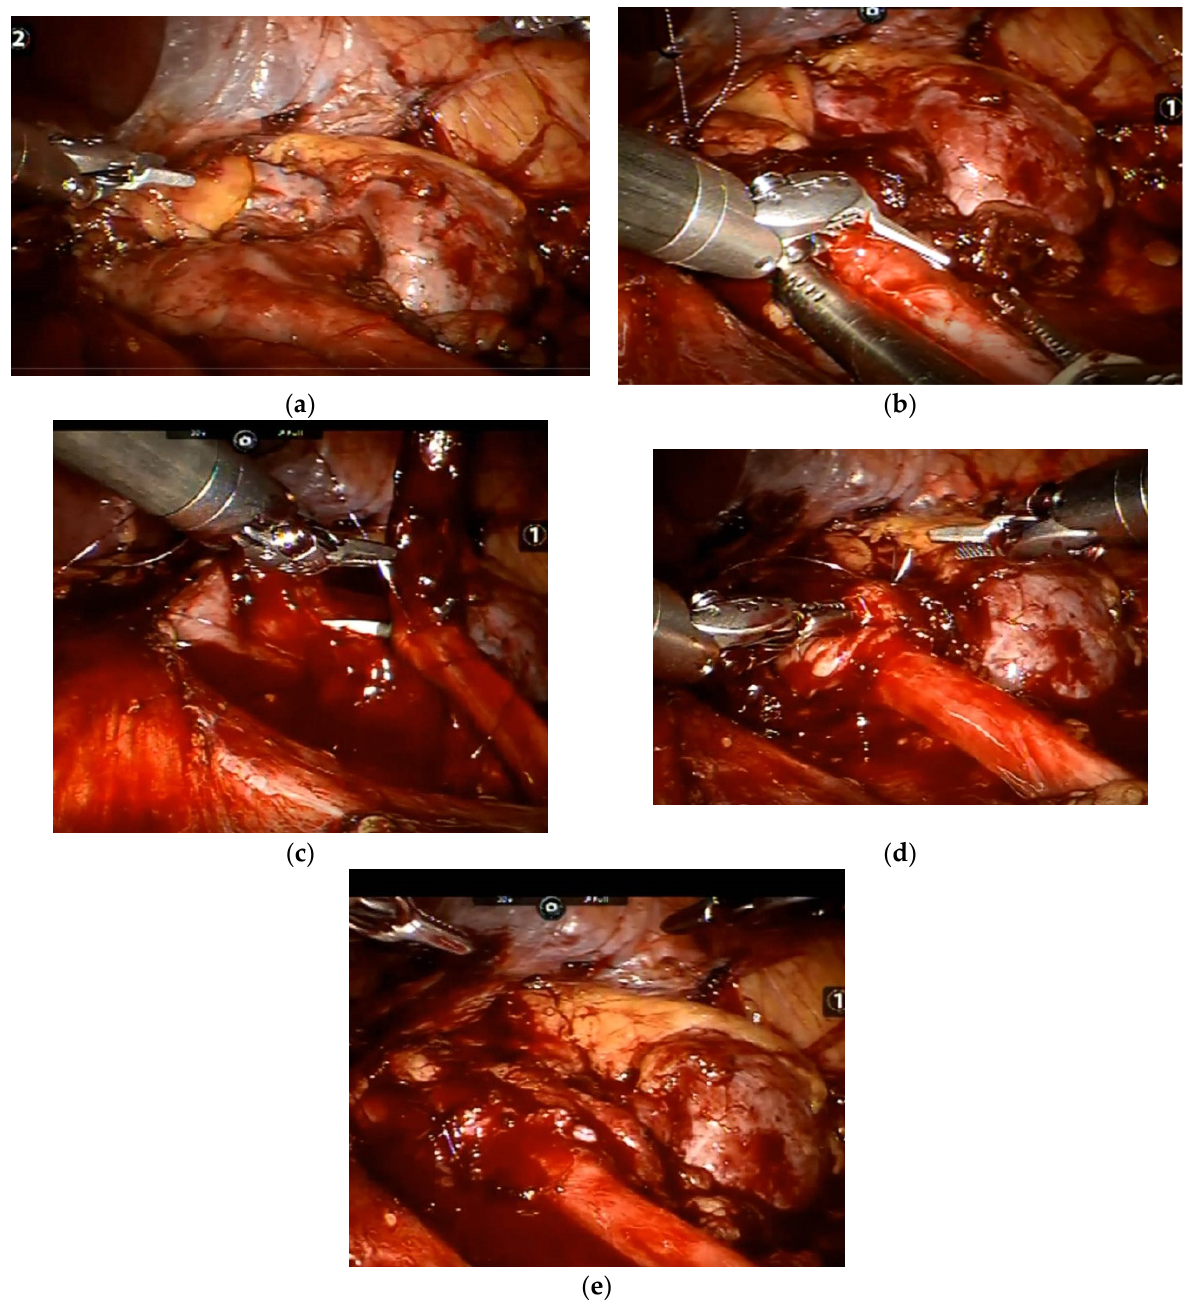
Figure 1. Selected stages during robot-assisted pyeloplasty: ( a ) UPJ exposure; ( b ) ureteral spatulation in the lateral aspect after resecting the sick UPJ portion; ( c ) uretero-pelvis anastomosis in the posterior aspect over a ureteral JJ stent; ( d ) uretero-pelvis anastomosis in the anterior aspect; and ( e ) at the procedure’s conclusion.